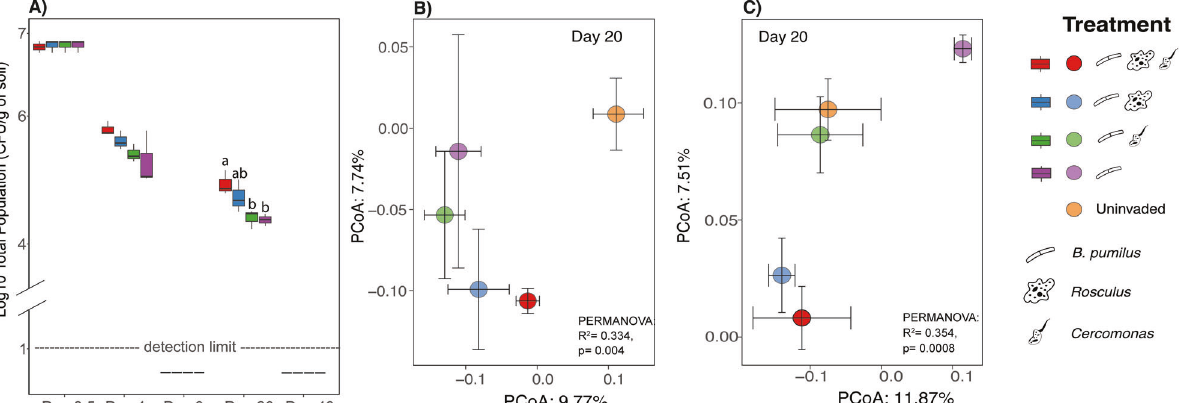
Fig. 4 Survival of Bacillus pumilus ECOB02 and the impact of inoculation treatments on the soil bacterial and protist communities structure. ( A ) Survival of Bacillus pumilus ECOB02 in the presence and absence of Rosculus terrestris ECOP02 and Cercomonas lenta ECOP01 over time. Values represent the log CFU of the population per gram of soil. Bars represent the standard error of the mean. Inoculation treatment affects the soil bacterial ( B ) and protist ( C ) communities. Centroids for each treatment are shown along with their standard errors (error